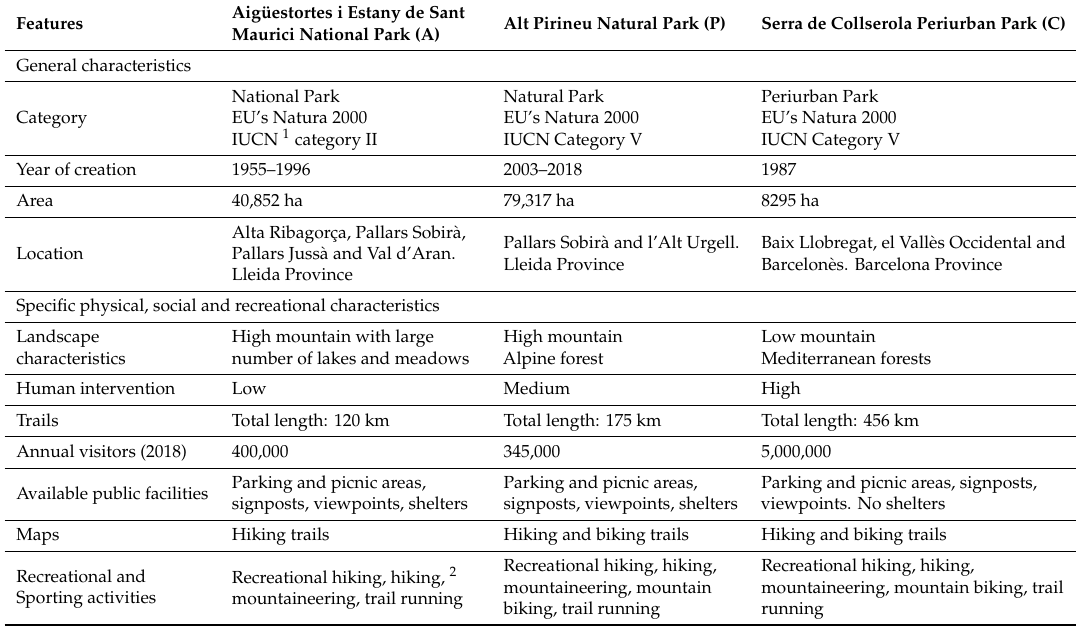
Table 1. Main characteristics of the